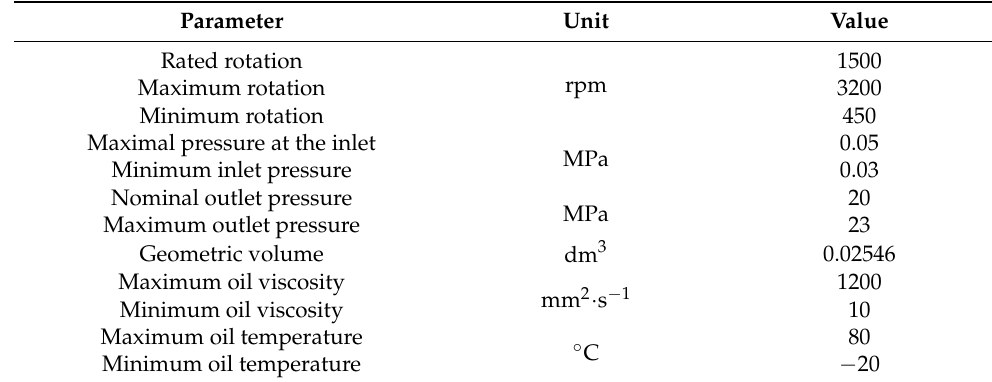
Table 2. Technical parameters of hydrostatic transducer UD–25 R.